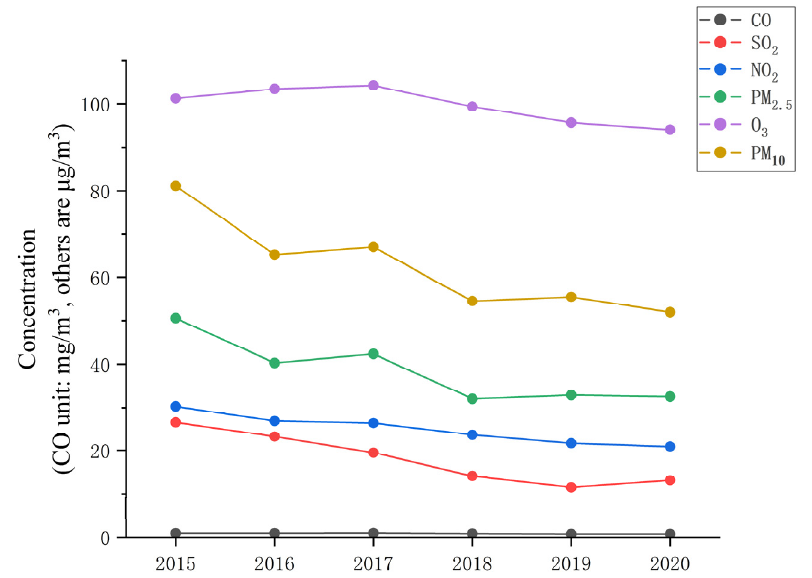
Figure 5. Change trend in annual average concentrations of six pollutants (CO, SO 2 , NO 2 , O 3 , PM 2.5 , PM 10 ) in the eastern Jilin Province, China, from 2015 to 2020 (CO unit: mg/m 3 , others are μ g/m 3 ).